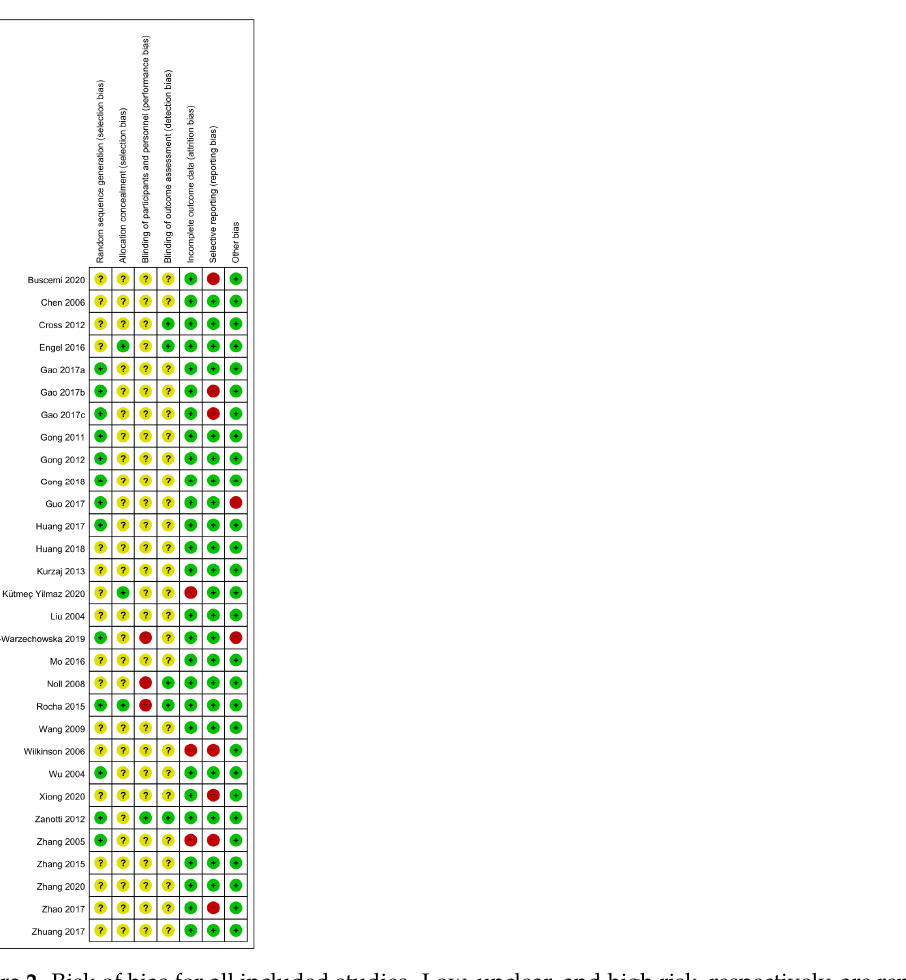
Figure 2. Risk of bias for all included studies. Low, unclear, and high risk, respectively, are repre- sented with the following symbols: “+”, “?”, and “ − ”. 3.4. Effectiveness and Safety of Manual Therapies Using Pair-Wise Meta-Analysis Manipulation showed no differences compared with sham in lung functions (FEV1: MD 0.23 L, 95% CI from − 0.12 to 0.58; FVC: MD − 0.02 L, 95% CI from − 0.57 to 0.53; FEV1/FVC: MD 3.01%, 95% CI from − 6.90 to 12.92), exercise capacity (6MWD: MD 64.80 m, 95% CI from − 12.94 to 142.54), and incidence of AE (RR 0.50, 95% CI: from 0.11 to 2.38). Additional massage significantly improved FEV1/FVC (MD 20.00%, 95% CI from 15.46 to 24.54) and total effective rate (TER) calculated using the severity of respiratory symptoms (RR 1.17, 95% CI from 1.00 to 1.38), compared with ROC alone. However, there were no differences between them in the FEV1 (MD 0.68 L, 95% CI from − 0.62 to 1.99), 6MWD (MD 56.20 m, 95% CI from − 8.18 to 120.58), and incidence of AE (RR 8.89, 95% CI from 0.48 to 165.55). When comparing additional acupressure with ROC alone, although there was no difference in FEV1 (MD 0.05 L, 95% CI from − 0.24 to 0.34) and FEV1/FVC (MD 0.84%, 95%